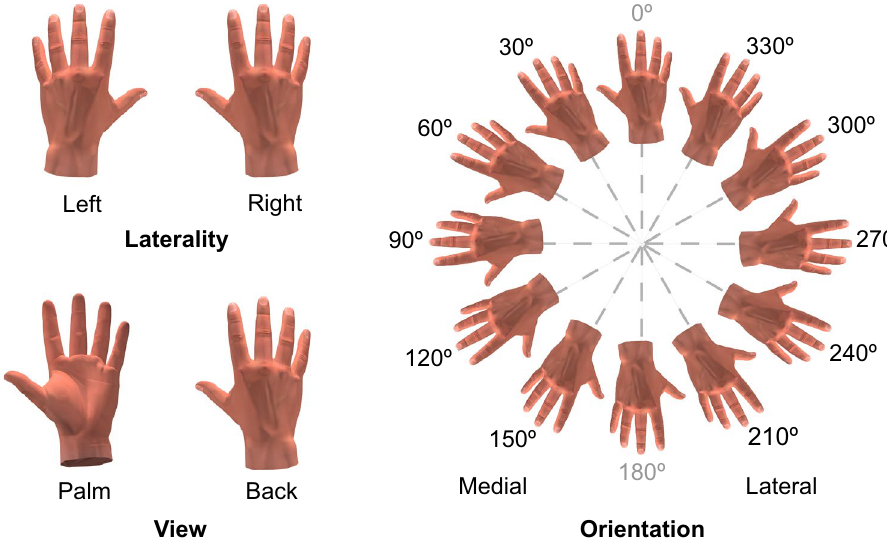
Figure 2. Experimental stimuli. Hand stimuli varied in terms of laterality, view and